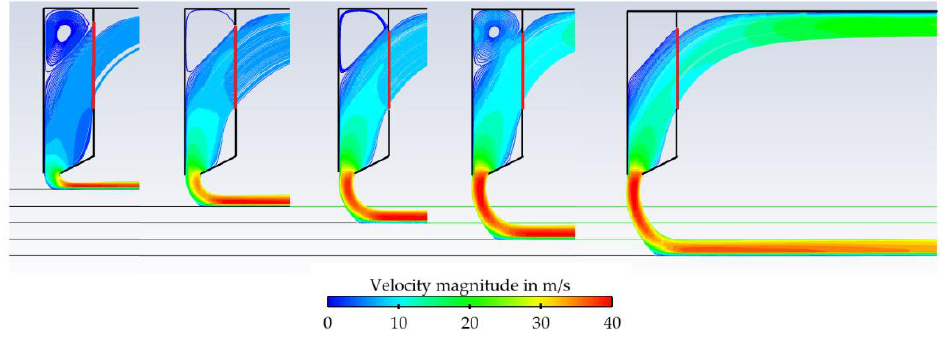
Figure 4. Velocity values on pathlines passing through a fan with a constant pressure increment of 1000 Pa for different curtain heights (from the left: 10 mm, 20 mm, 30 mm, 40 mm, 50 mm) and nozzle width of 10 mm.